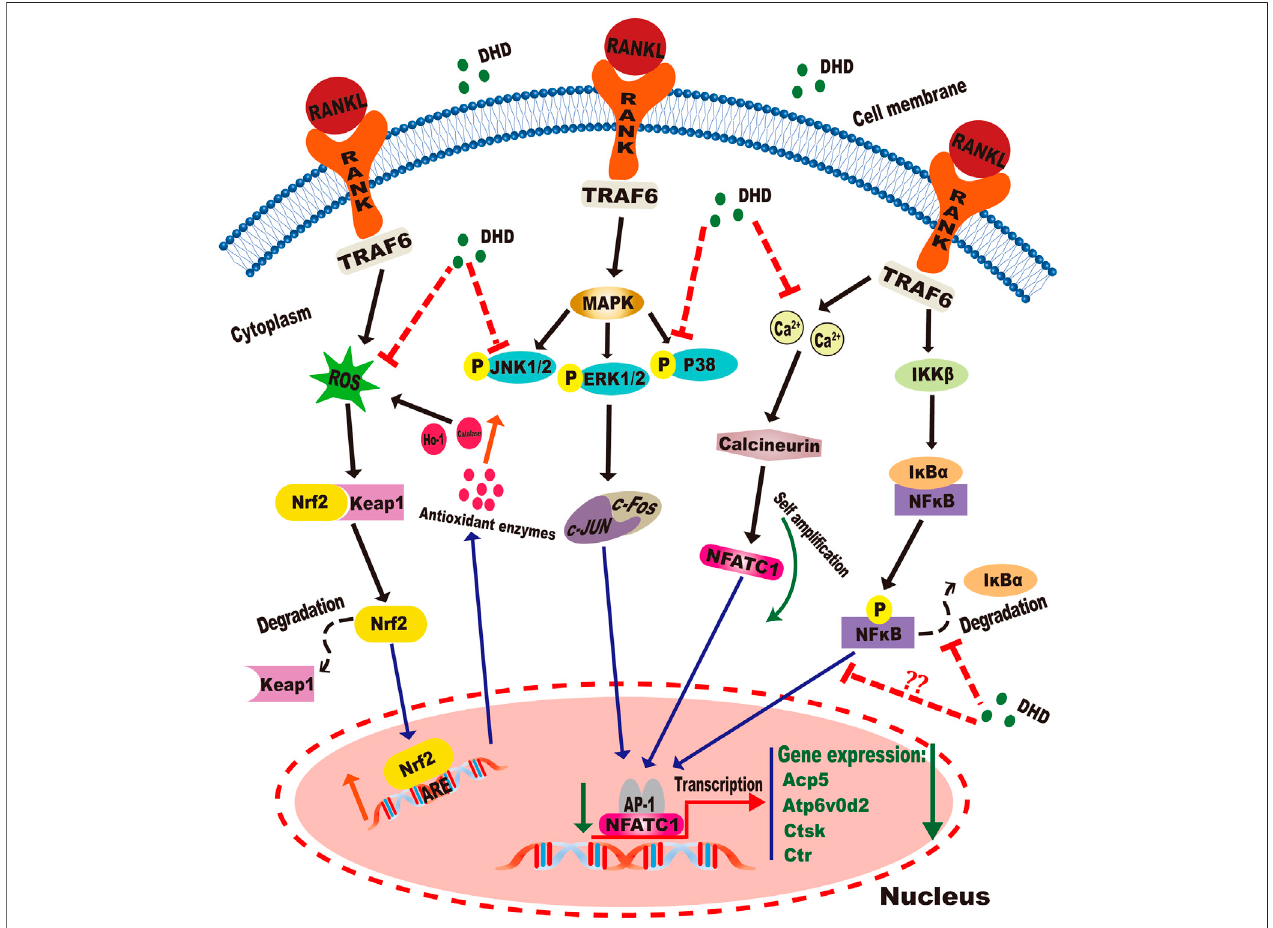
FIGURE 11 | Graphical abstract for illustrating the role of DHD in repressing RANKL-mediated osteoclastogenesis through inhibition of MAPK, calcium, and Nrf2/ Keap1/ARE signaling pathways.